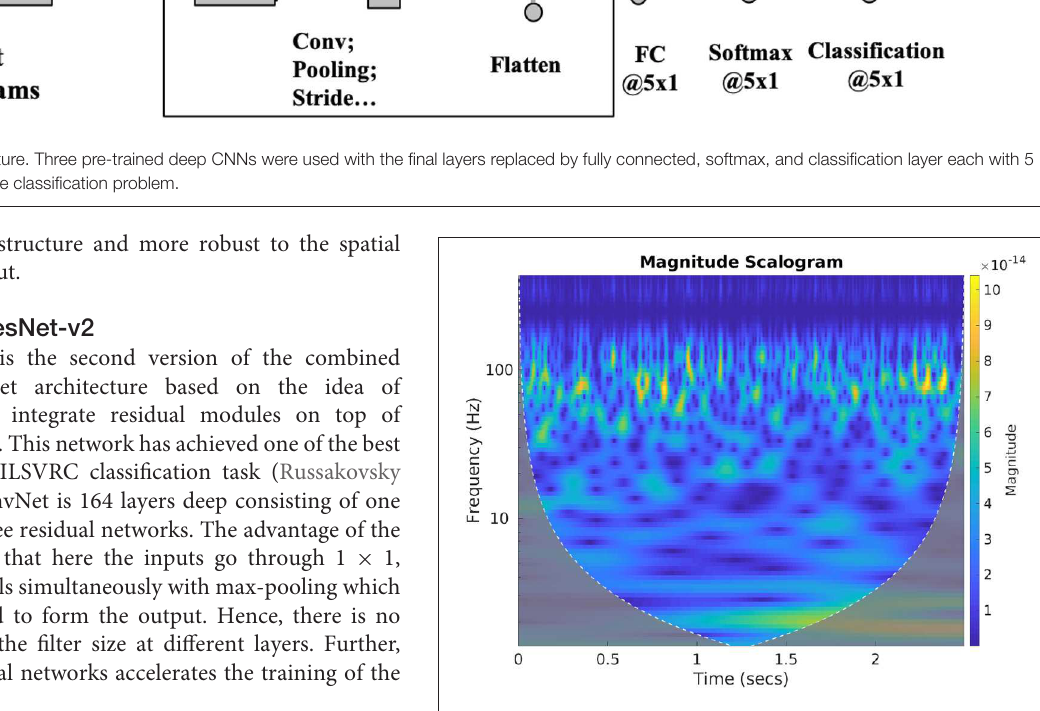
FIGURE 6 | Scalogram plot of neural signal. The image represents the cone of influence (COI) plot of the scalogram representation of the brain signal obtained from a sensor near Broca’s area. This is when the subject was speaking “Do you understand me.” The color bar represents the change in energy of various CWT coefficients obtained with Morlet